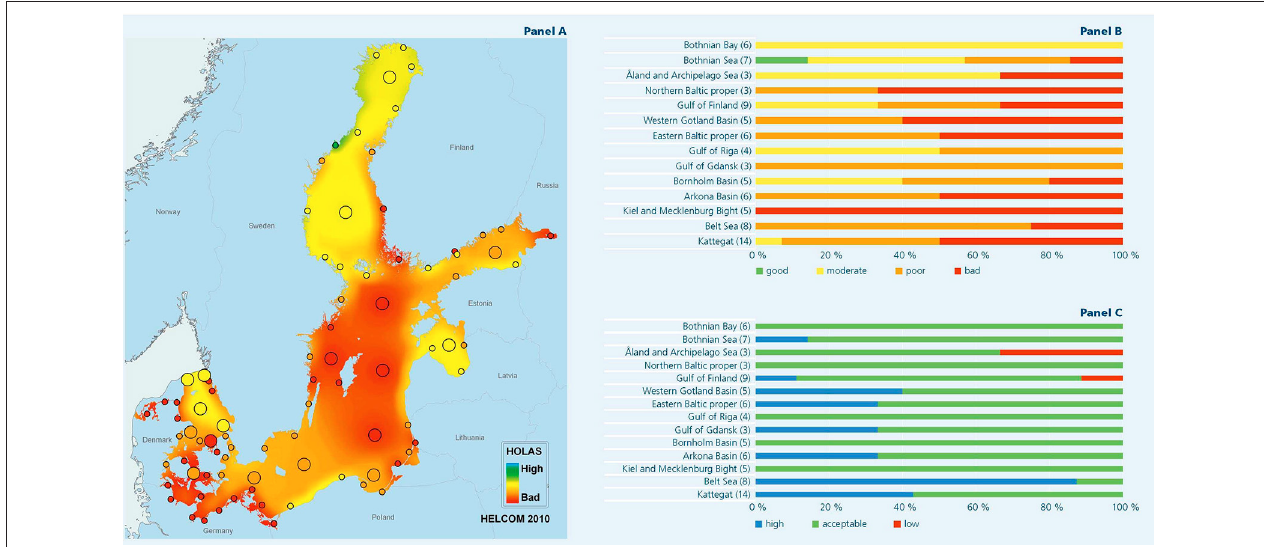
FIGURE 4 | Classification of “ecosystem health status” in the Baltic Sea. In panel (A) , classifications are spatially interpolated in order to illustrate that the impairment is a large scale problem. Panel (B) shown classification per sub-region [expressed as good (green), poor (yellow), poor (orange), or bad (red)], while panel (C) shows the confidence assessment of the classifications per sub-region [expressed as a high confidence (blue), a moderate but acceptable confidence (green), and a low confidence (red)]. See HELCOM (2010a) for details.